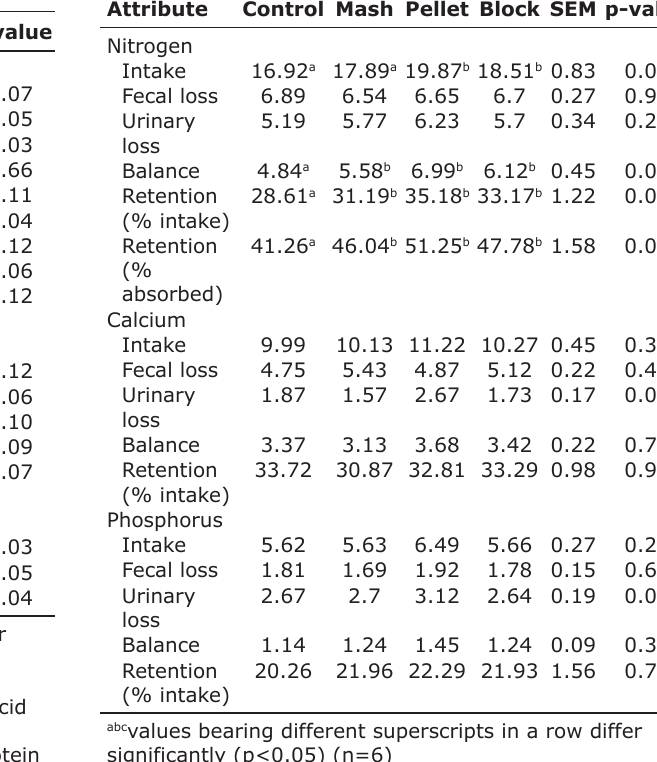
Table-3: Effect of feeding differently processed sorghum stover-based complete rations on nitrogen, calcium, and phosphorus balance (g d -1 ) in